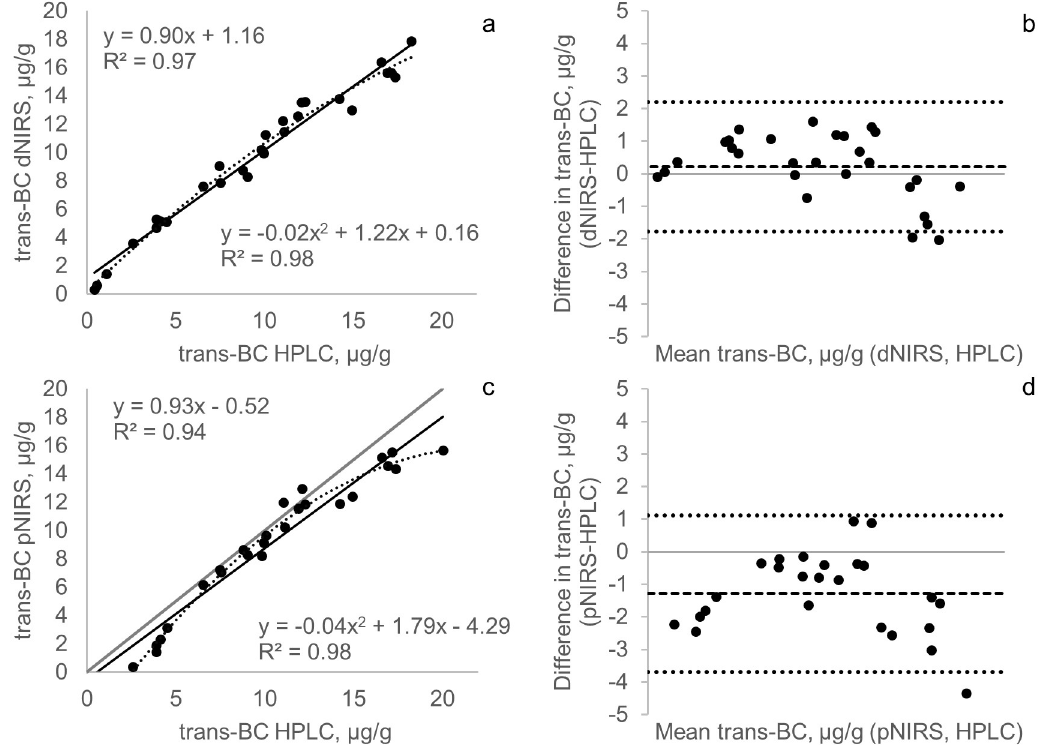
Fig 3. Scatterplot and Bland Altman comparison between trans-BC measured by HPLC versus dNIRS (a-b) and pNIRS (c-d). The black lines indicate linear regression lines and the dotted lines indicate quadratic regression lines. Gray lines represent the line of identity. The square dotted lines represent the bias and the round dotted lines indicate the 95% confidence